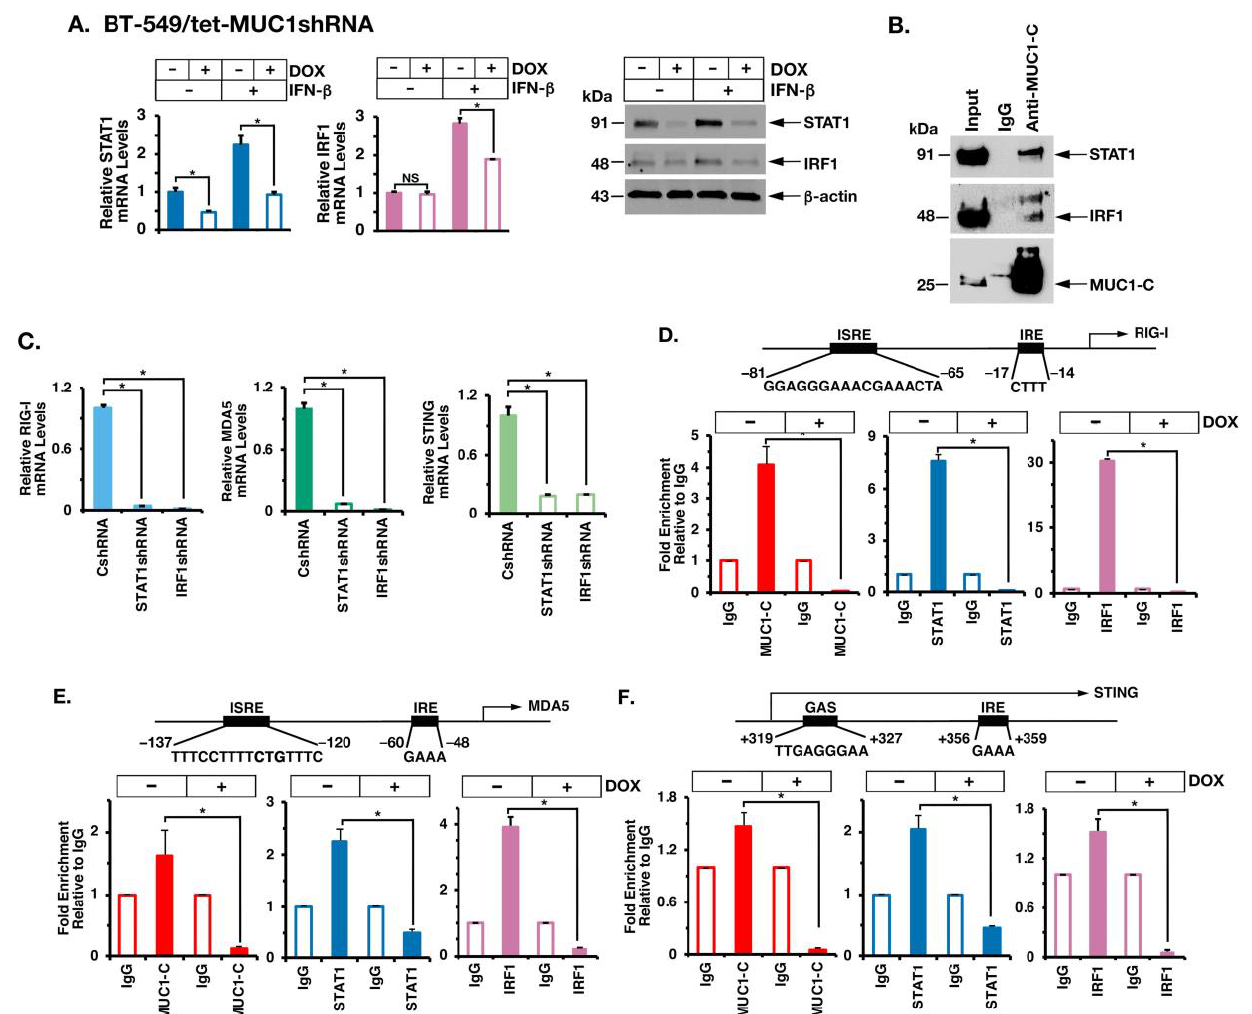
Figure 5. MUC1-C forms a nuclear complex with STAT1 and IRF1 in activating RIG-I, MDA5 and STING. ( A ) BT-549/tet-MUC1shRNA cells treated with vehicle or DOX for 7 days and stimulated with IFN-β for 4 h were analyzed for STAT1 and IRF1 mRNA levels by qRT-PCR (left). The results (mean ± SD of 4 determinations) are expressed as relative mRNA levels compared to that obtained for vehicle-treated cells (assigned a value of 1). Lysates were immunoblotted with antibodies against the indicated proteins (right). ( B ) Nuclear lysates from BT-549 cells stimulated with IFN-β for 4 h were precipitated with anti-MUC1-C and a control IgG. Input lysate and the precipitates were immunoblotted with antibodies against the indicated proteins. ( C ) BT-549 cells expressing a control CshRNA, STAT1shRNA or IRF1shRNA were analyzed for the indicated mRNA levels by qRT-PCR. The results (mean ± SD of 4 determinations) are expressed as relative mRNA levels compared to that obtained for the CshRNA cells (assigned a value of 1). ( D – F ) Schemas of the RIG-I ( D ), MDA5 ( E ) and STING ( F ) promoter regions with highlighting localization of ISREs, IREs and GAS. Soluble chromatin from BT-549/tet-MUC1shRNA cells treated with vehicle or DOX for 7 days was precipitated with a control IgG, anti-MUC1-C, anti-STAT1 and anti-IRF1. The DNA samples were amplified by qPCR with primers for the respective promoter regions. The results (mean ± SD of 3 determinations) are expressed as fold enrichment relative to that obtained with the IgG control (assigned a value of 1). The asterisk (*) denotes a p -value < 0.05. Uncropped Western Blots can be found at supplemental original images.